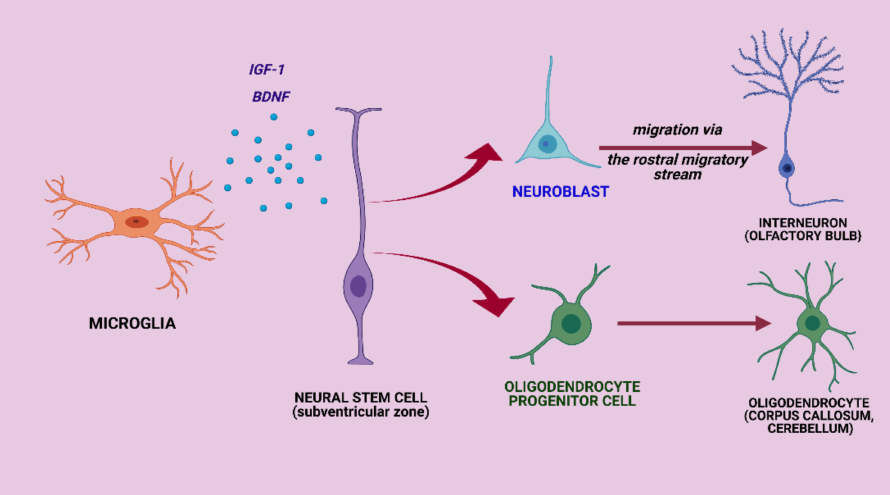
Figure 3. Neural stem cell niche. Under physiological conditions, the subventricular zone contin- uously provides neural progenitor cells that differentiate into neuroblasts, which migrate via the rostral migratory stream to the olfactory bulb, where they become interneurons [115,120]. Through IGF-1 and BDNF, microglia direct the neural stem cells towards the olfactory bulb, help them dif- ferentiate into interneurons, and integrate in the local circuitry [115,120]. The neural stem cell niche provides cells that are recruited in the corpus callosum and cerebellum and contribute to normal myelinogenesis by maintenance of the local oligodendrocyte population [124]. Insulin-like growth factor-1 (IGF-1), brain derived neurotrophic factor (BDNF). Created with BioRender.com (accessed on: 7 March